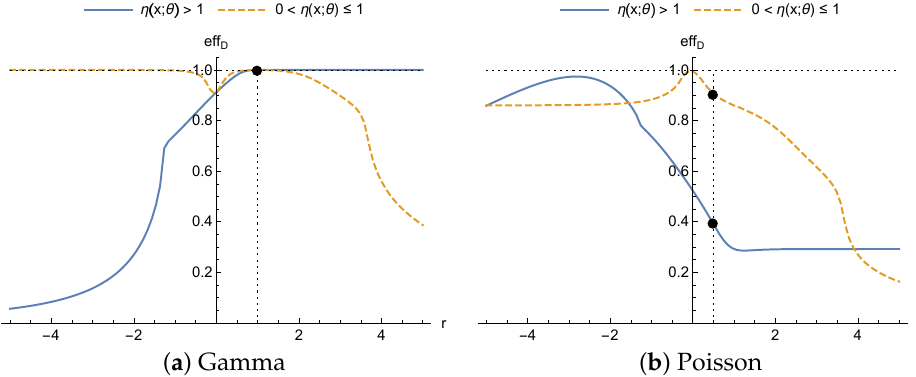
Figure 3. Study of efficiency trend when comparing the designs obtained for the heteroscedastic normal distribution as a function of the parameter r of (5) considering the gamma ( a ) or Poisson ( b ) distributions as the true distributions, for the 4-parameter Hill model in X = [ 0,1500 ] . Solid lines assume E con = 10 and b = 1 (therefore η ( x ; θ ) > 1), while for dashed lines E con = 1 and b = 0.1 (0 < η ( x ; θ ) ≤ 1). Both cases use the nominal values IC 50 = 550 and s = −